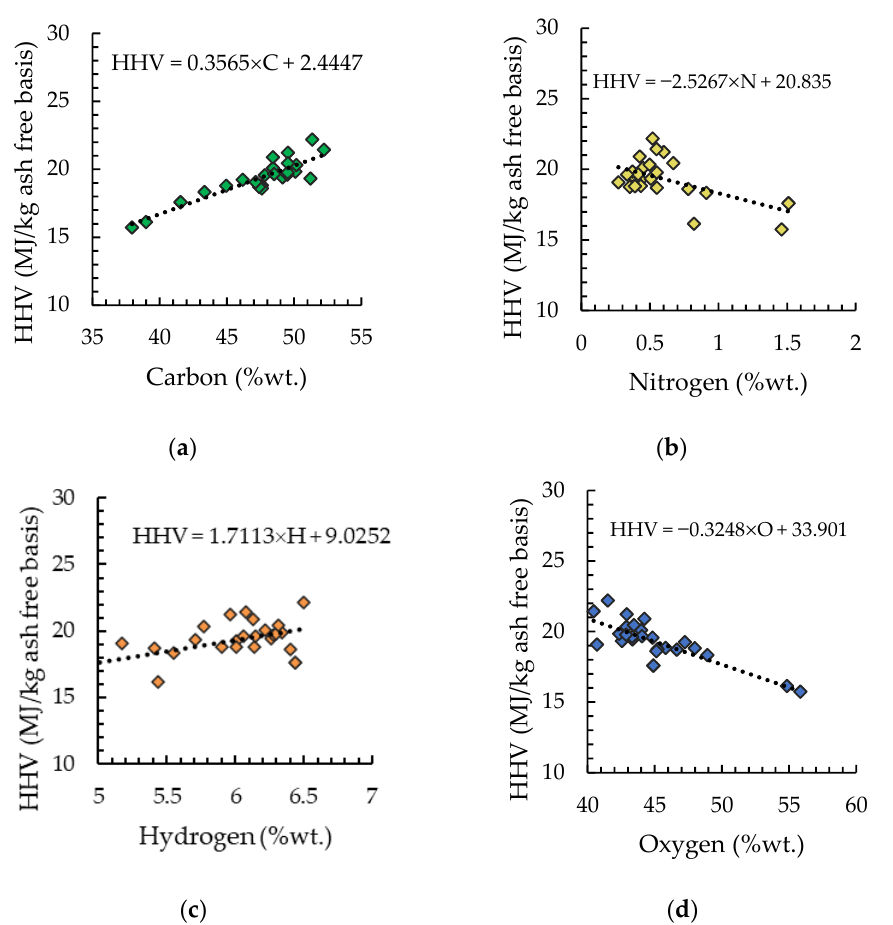
Figure 6. Correlations between HHVs and chemical elements in the ultimate analysis on an ash-free basis: ( a ) carbon; ( b ) nitrogen; ( c ) hydrogen; ( d ) oxygen.